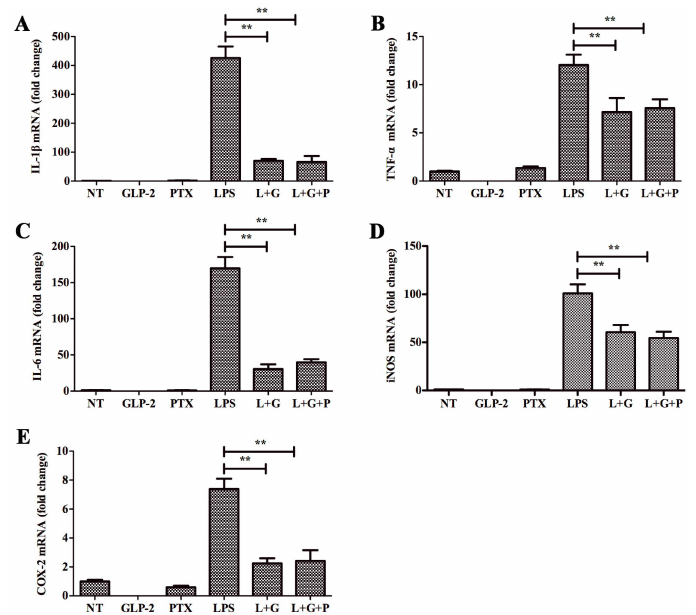
Figure 5. Effects of GLP-2 did not mediate by G α i/o signaling pathway. BV-2 cells were pretreated with vehicle or PTX for 1 h. Medium was removed and replaced with vehicle, GLP-2 (10 ´ 6 M), pertussis toxin (PTX) (100 ng/mL), LPS (1 µ g/mL), LPS + GLP-2 (L + G), or LPS + GLP-2 + PTX (L + G + P). BV-2 cells were sampled at 4 h. The mRNA of pro-inflammatory enzymes and pro-inflammatory cytokines were determined by quantitative real-time PCR. Attenuation by GLP-2 of LPS-induced mRNA of IL-1 β ( A ); TNF- α ( B ); IL-6 ( C ); iNOS ( D ); and COX-2 ( E ) from BV-2 cells; this effect is not abolished with pretreatment with PTX, ** p <